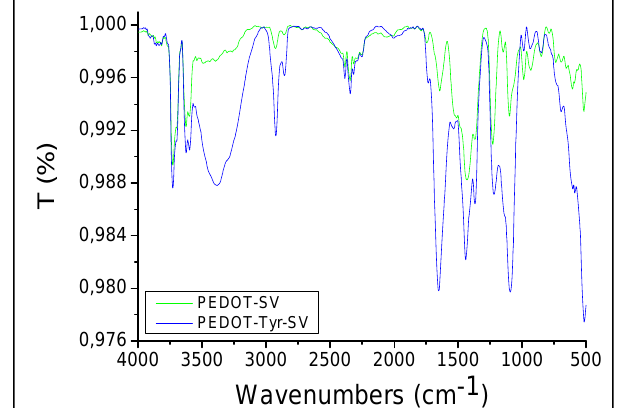
Figure 3. IRRAS spectra recorded for PEDOT and PEDOT-Ty coatings deposited using excitation amplitudes of 50